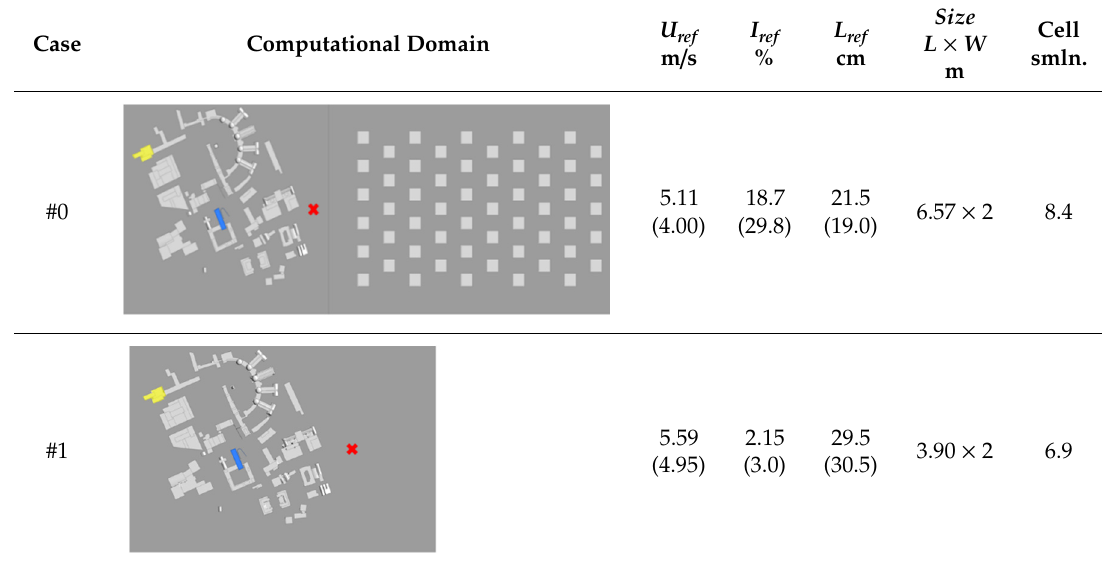
Table 1. Computational domains used in this study, showing the respective inlet turbulence generated at the height of MT ( z M = 0.2 m) and BB ( z B = 0.14 m). The reference inflow properties are measured 1 m upstream of the center of the test platform, as indicated by , and the building test- cases are colored by for the Biosciences tower and by for the Muirhead tower.